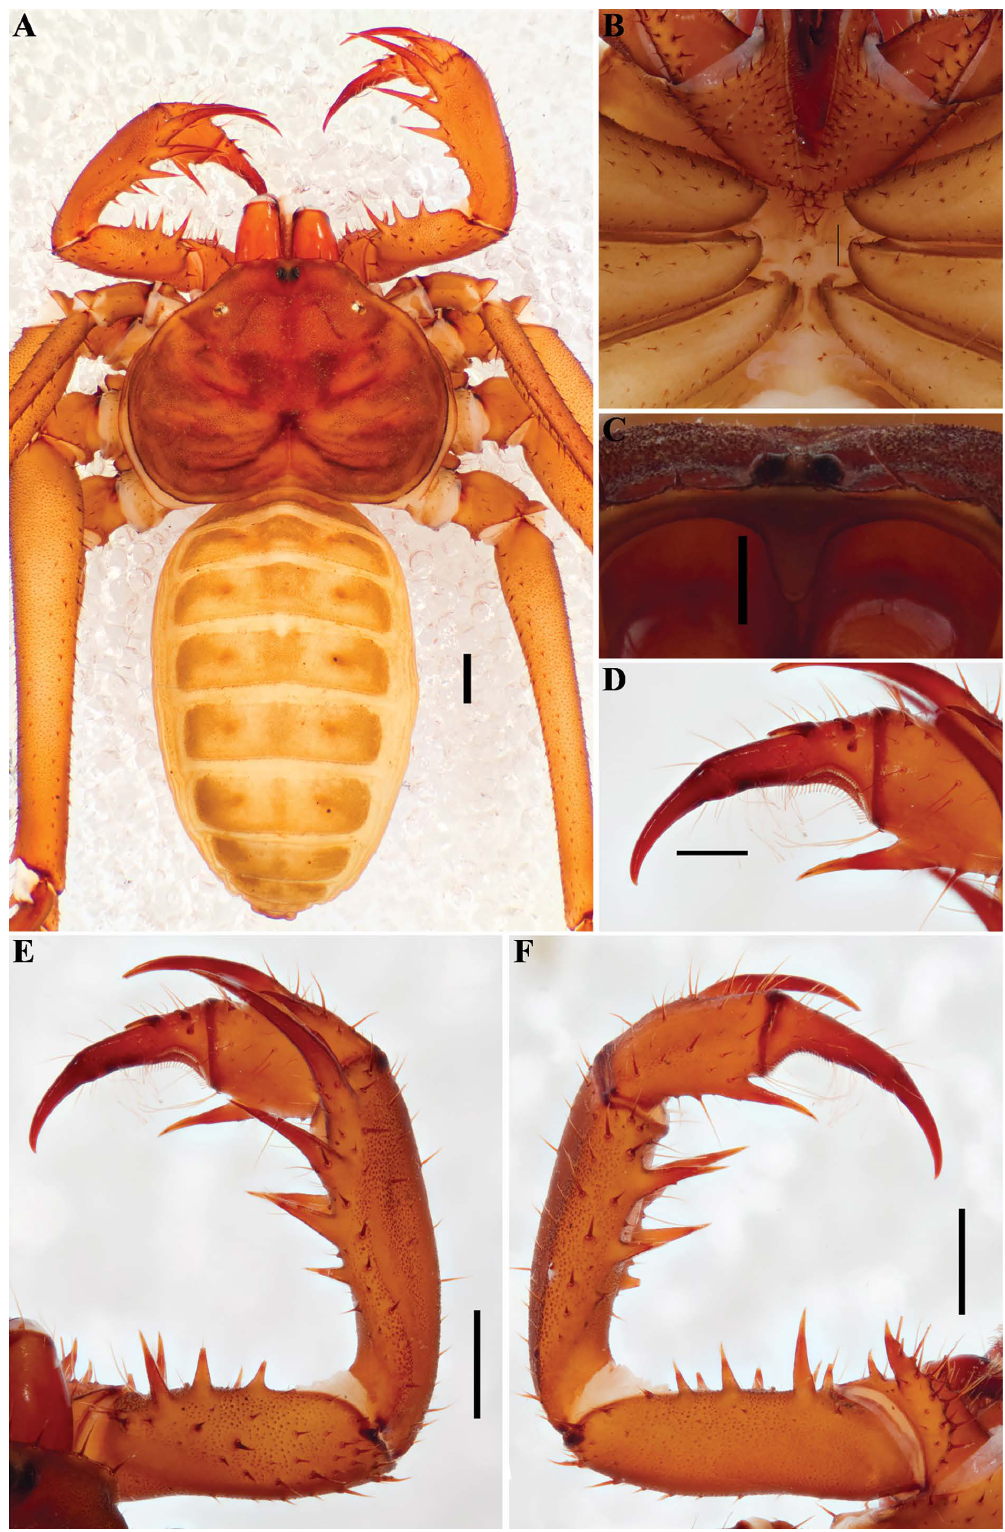
Fig. 90. Charinus loko sp. nov. (SMNS), general morphology, ♀. A . Habitus, dorsal view. B . Sternum, ventral view. C . Frontal process. D . Pedipalp tarsus, frontal view. E . Pedipalp, dorsal view. F . Pedipalp, ventral view. Scale bars: A, E–F = 1 mm; B–D = 0.5